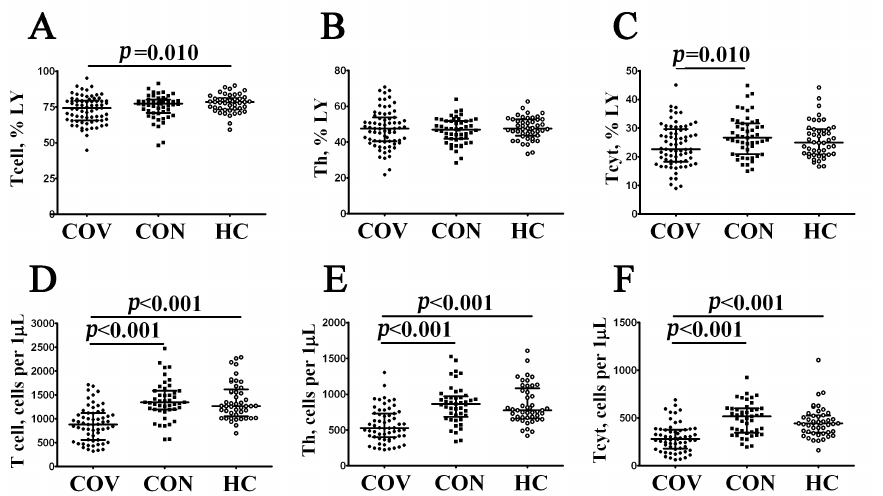
Figure 3. 3 Figure 3. Comparison of relative and absolute frequencies of major T cell subsets in patient with acute COVID-19 and convalescent COVID-19 individuals. Scatter plots ( A – C ) and ( D – F ) showing the percentages (the percentage of T cell subset within total lymphocyte population) and absolute numbers (number of cells per 1 µ L of peripheral blood) of T cells (CD3+), T-helpers (Th, CD3+CD4+), and CD8+ T cells (Tcyt, CD3+CD8+), respectively. Black circles denote patients with acute COVID-19 (COV, n = 71); black squares—convalescent COVID-19 individuals (CON, n = 51); white circles— healthy control (HC, n = 46). Each dot represents individual subject, and horizontal bars depict the group medians and quartile ranges (Med (Q25; Q75). In Figure 3, the statistical analysis was performed with the Mann–Whitney U test.